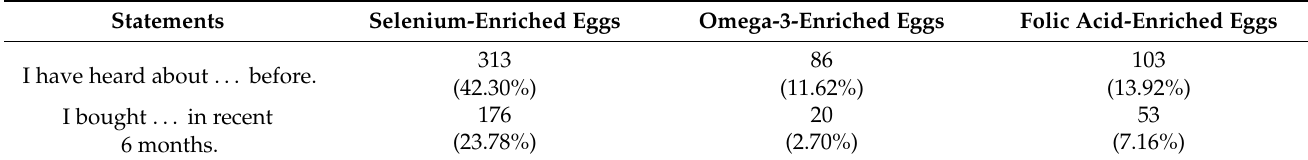
Table 3. Participant’s cognition and purchase experience of the nutrition fortified